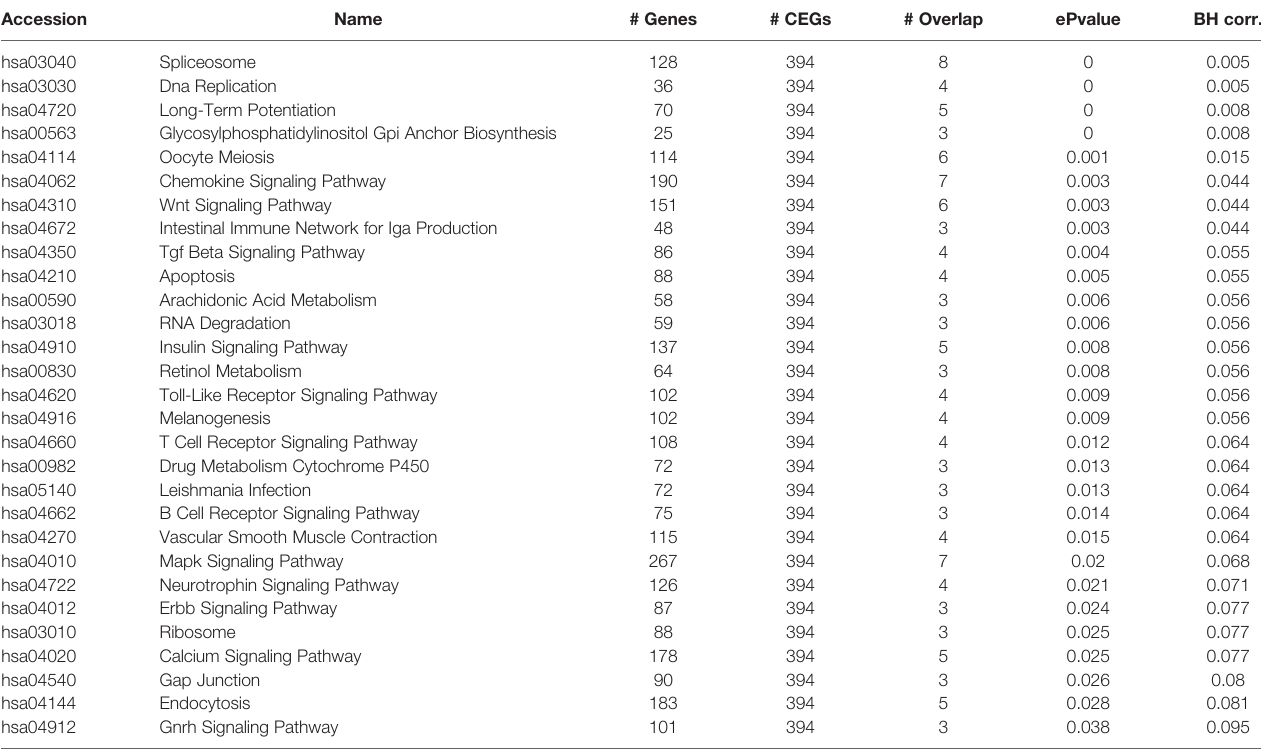
TABLE 1 | Enrichment pathway of co-expression molecules of FGD5-AS1 at 12 and 24 hpi.